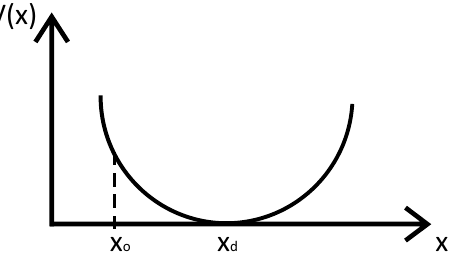
Figure 2. Lyapunov candidate function and corresponding state.